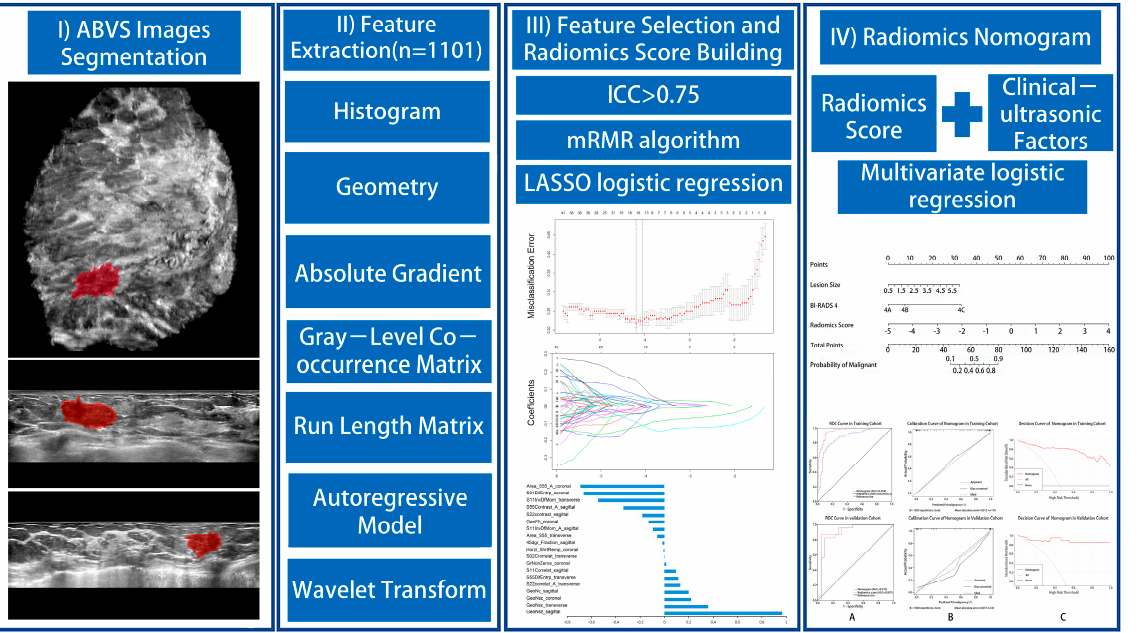
Figure 1. Workflow of necessary steps in this study. BI-RADS 4 lesions are manually segmented on axial, sagittal, and coronal ABVS images. Radiomic features are automatically extracted by MaZda software. A three-step feature selection technique to identify key radiomic features and incorporate them into the radiomic score was used. Combined with radiomic score and clinical-ultrasound factors, the ABVS radiomic nomogram was constructed by univariate and multivariate logistic regression analyses. The performance of the nomogram was assessed by the area under a receiver operating characteristic (ROC) curve, calibration curve, and decision curve